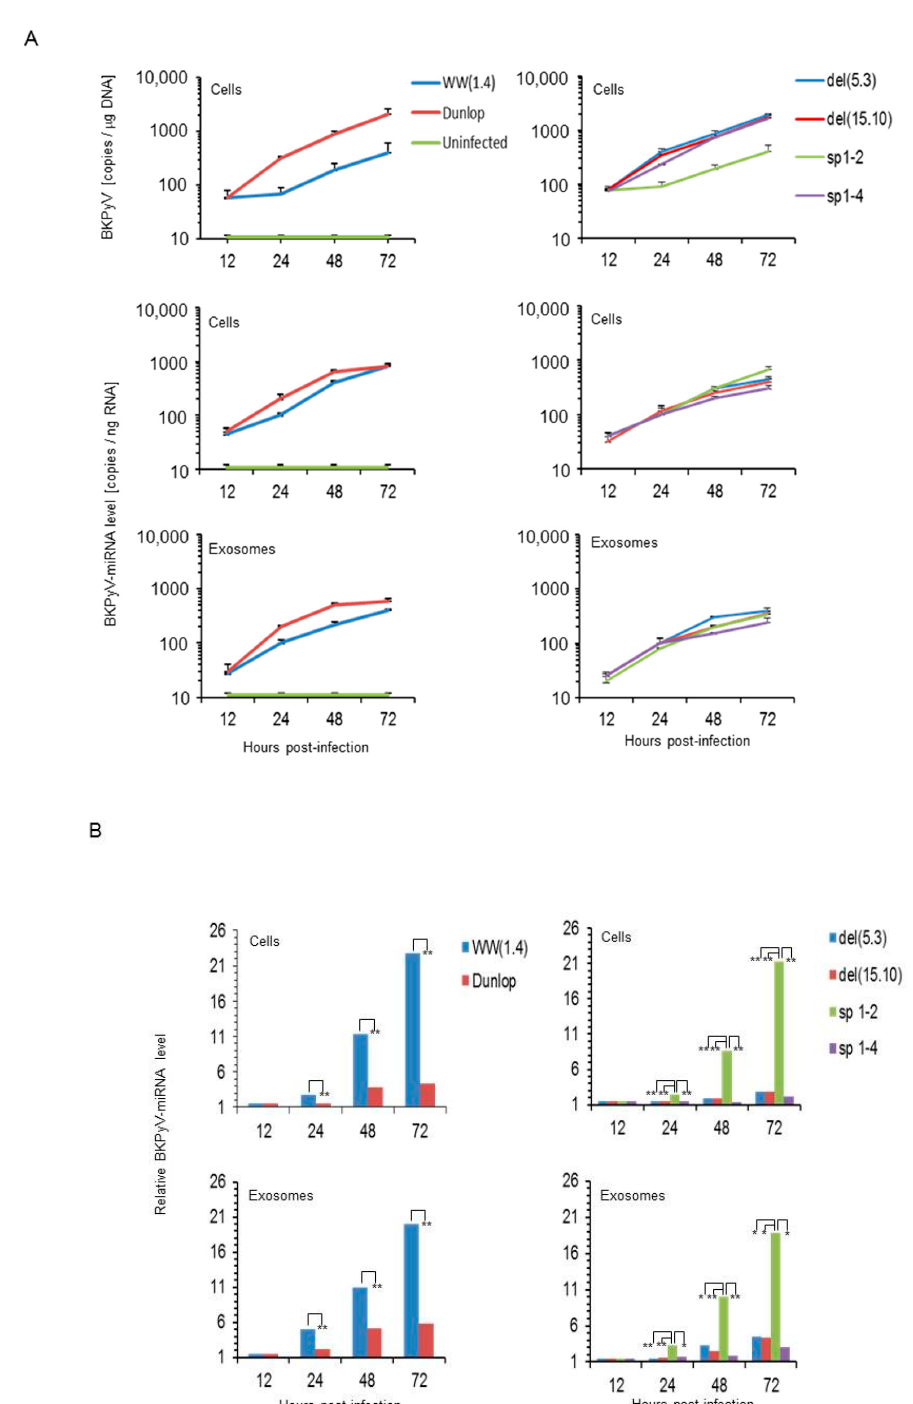
Figure 2. Viral replication and miRNA levels of archetype and different laboratory- or patient-derived BKPyV variants in cell culture. ( A ) Cos-7 cells were infected with the indicated strains (Figure 1) and viral load and BK-miRNA-5p expression were measured in cells and exosome preparations at 12, 24, 48 and 72 h post infection. BKPyV genome load was expressed per total µg DNA; miRNA given per total ng RNA (mean ± standard deviation of 3 independent experiments). ( B ) Time course comparing of miRNA expression levels in cells or exosome preparations following infection with archetype or indicated NCCR variant strains as described in Figure 1. Results are expressed as BKPyV -miRNA relative levels to DNA genome copy number normalized to archetype WW ( 1.4 ) clone values obtained at 12 h post-infection set to 1 (-fold; *, p < 0.05; ** p <